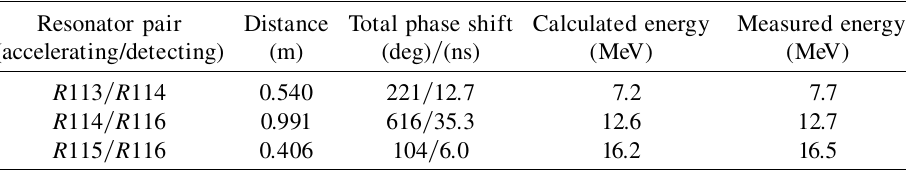
TABLE I. Comparison of phase-shift energy determination and solid-state detector mea- sured energy. Resonator pair Distance Total phase shift Calculated